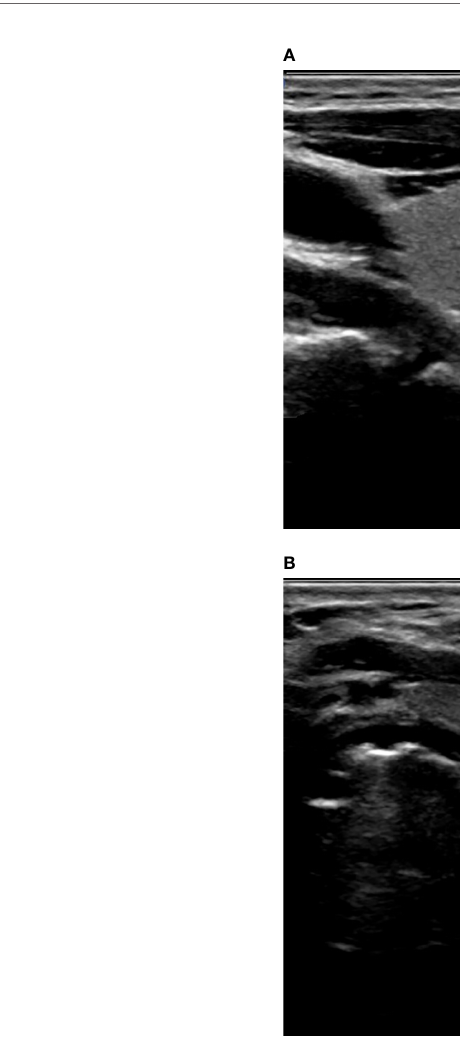
FIGURE 1 | 48-year-old man with thyroid papillary carcinoma. Sonographies of longitudinal scanning (A) and axial scanning (B) axial scanning show the nodule locates at the left lobe of the thyroid, characterized by 16.1 mm×13.8 mm×13.3mm in size, solid composition, irregular shape, A<T orientation in longitudinal view and A>T orientation in axial view, spiculated margin, heterogeneous iso/hypoechoic, with several punctate hyperechoic foci, and absence of posterior acoustic effect. C-TIRADS 5, K-TIRADS 5, ACR-TIRADS 5. Histopathology con fi rmed it is a papillary